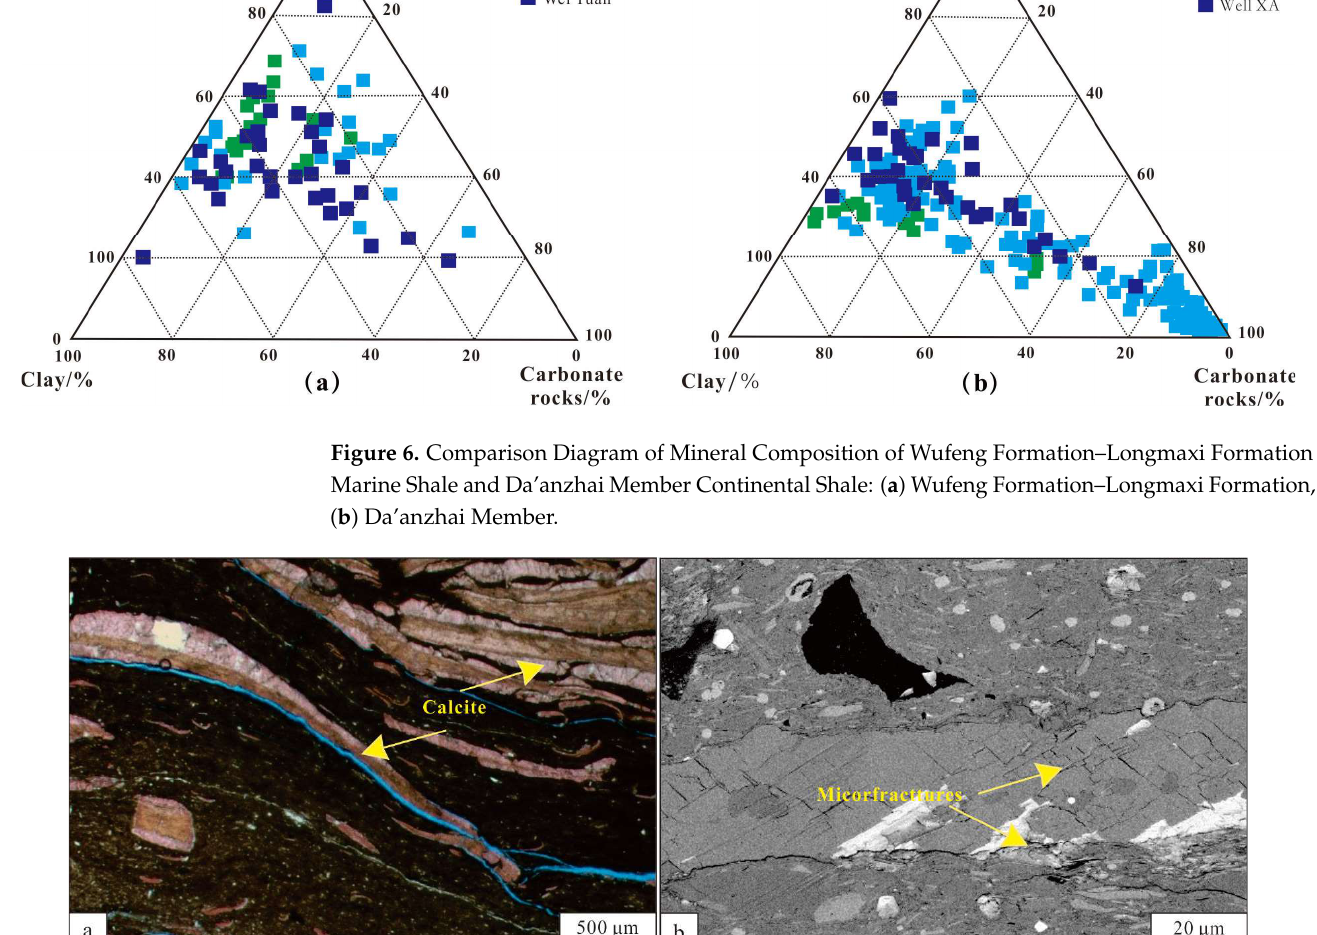
Figure 7. Characteristics of microfractures in the shell limestone interlayer. (a) A large amount of calcite in the shell. (b) A large number of microfractures develop in the shell.